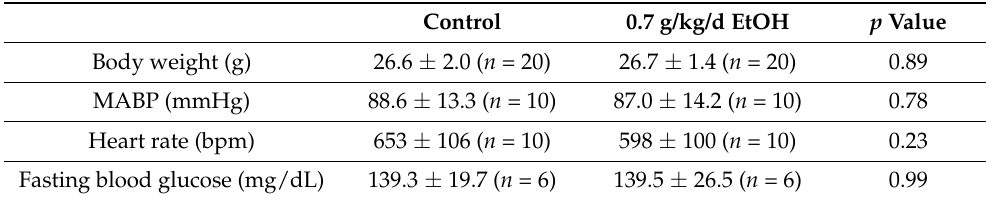
Table 1. Effects of LAC on body weight, MABP, heart rate, and fasting blood glucose. Values are means ± SD for 6–20 mice in each group. Analyzed using an unpaired t